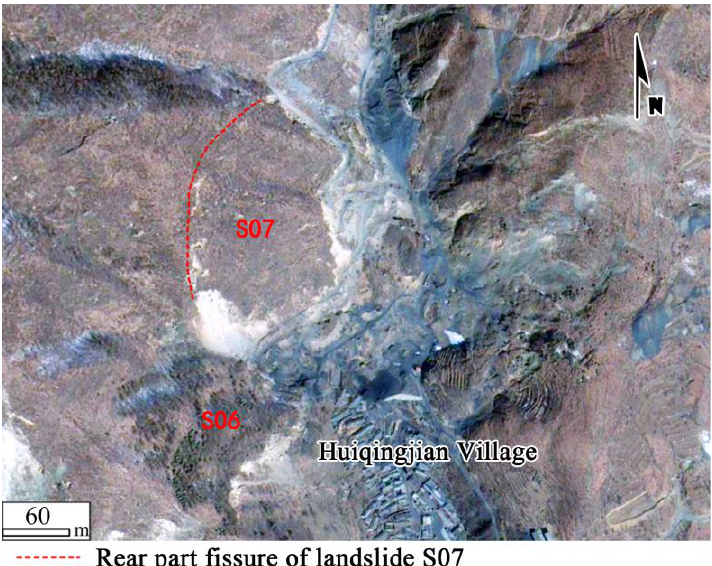
Figure 15. Optical image of landslides S06 and S07 in 2012.